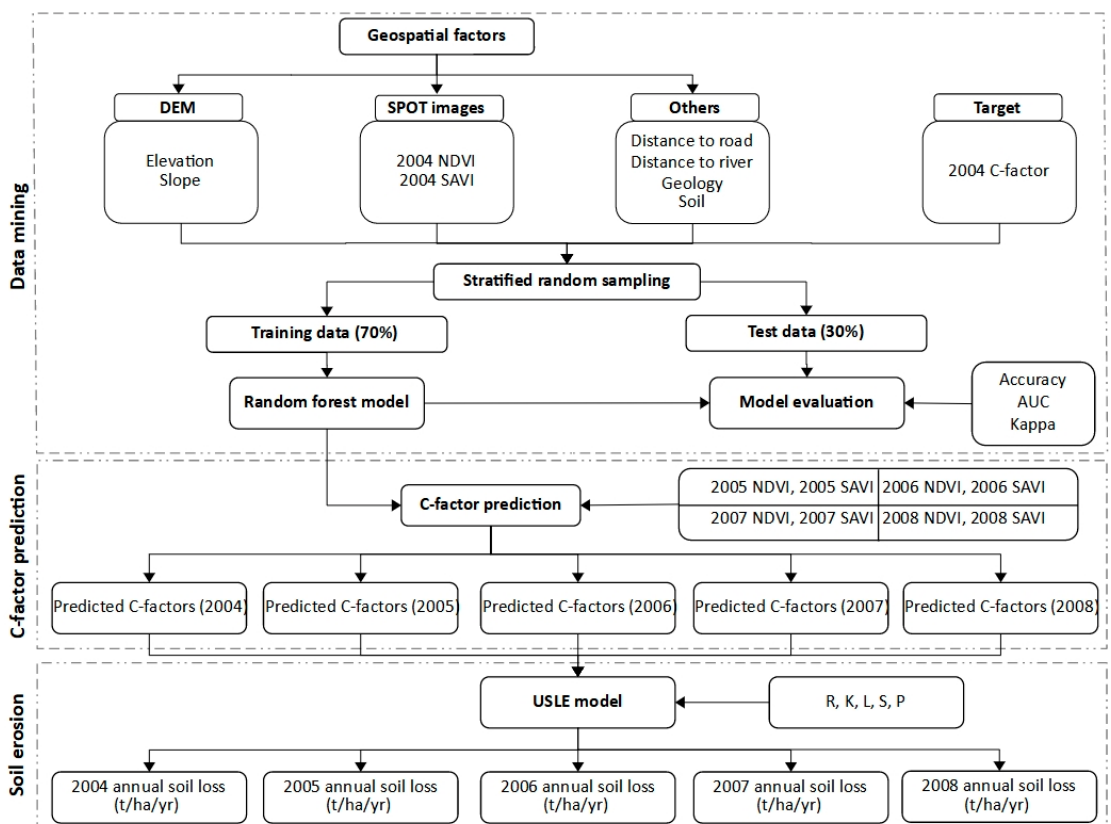
Figure 3. Research steps of this study.